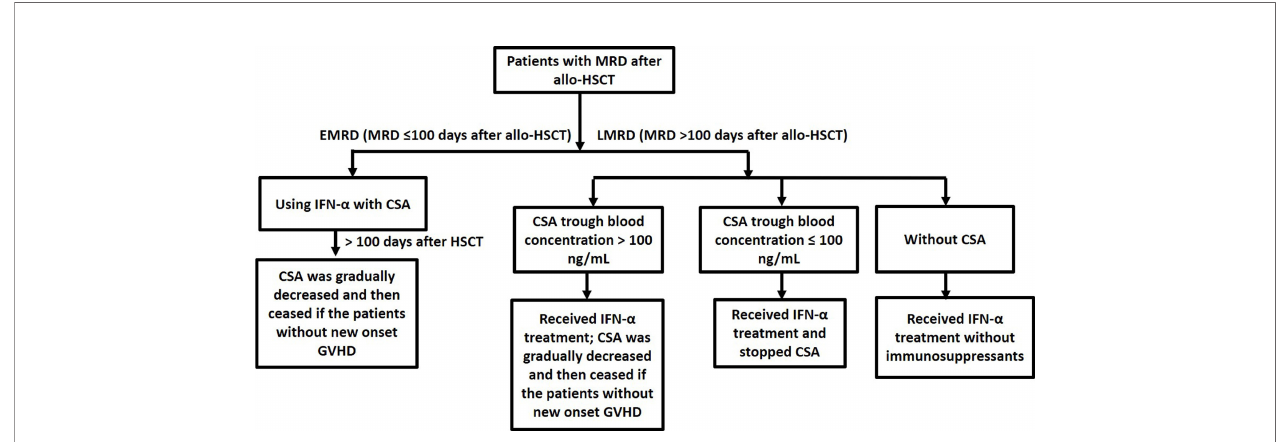
FIGURE 2 | Using cyclosporine A in MRD-positive patients who received preemptive IFN- a therapy